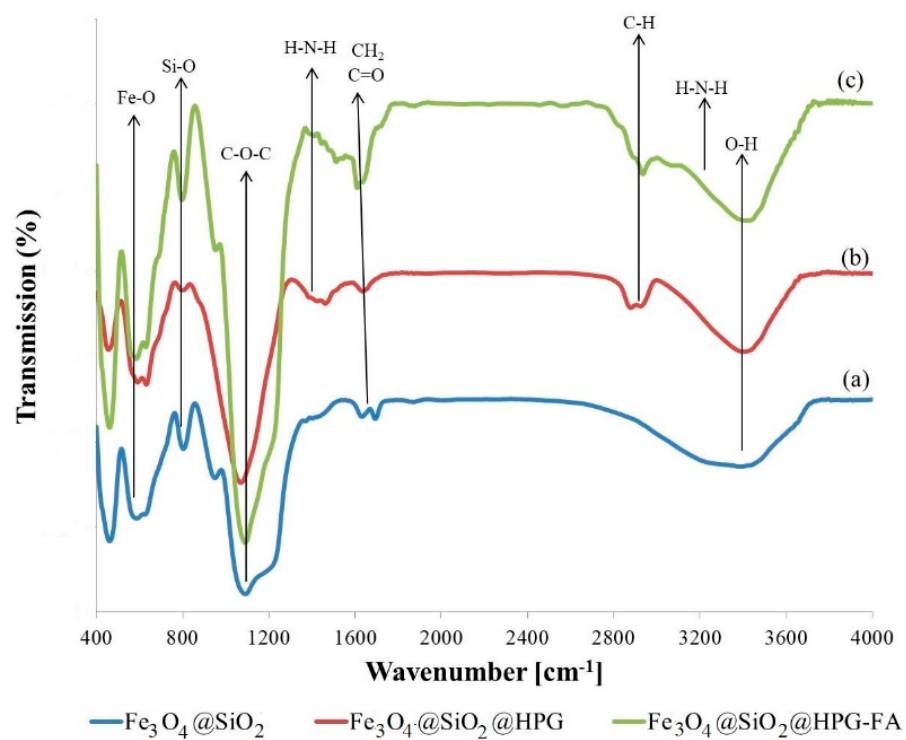
Figure 2. FT-IR spectroscopy of ( a ) Fe 3 O 4 @SiO 2 , ( b ) Fe 3 O 4 @SiO 2 @HPG, and ( c ) Fe 3 O 4 @SiO 2 @HPG-FA.